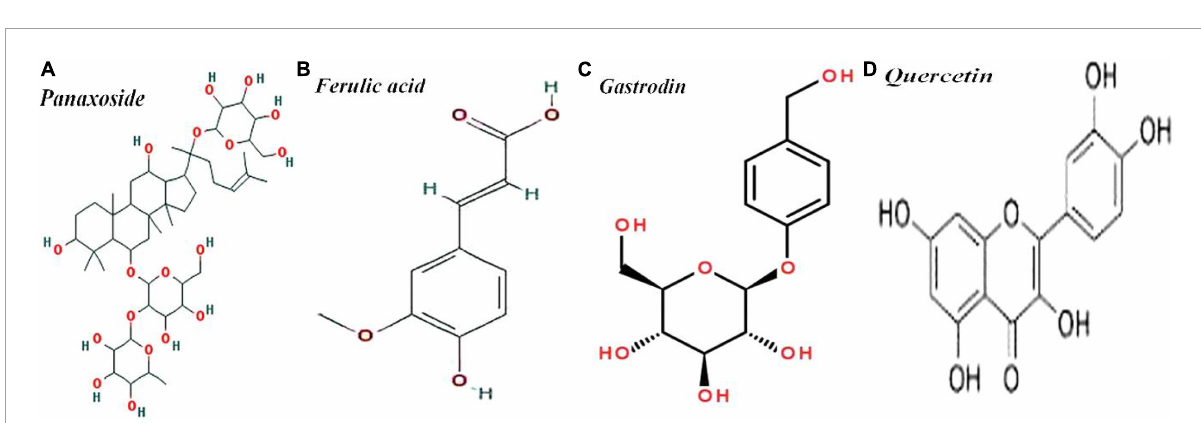
FIGURE2 Molecular structures of (A) panaxoside/C36H62O8, (B) ferulic acid/C10H10O4, (C) gastrodin/C13H18O7, and (D)